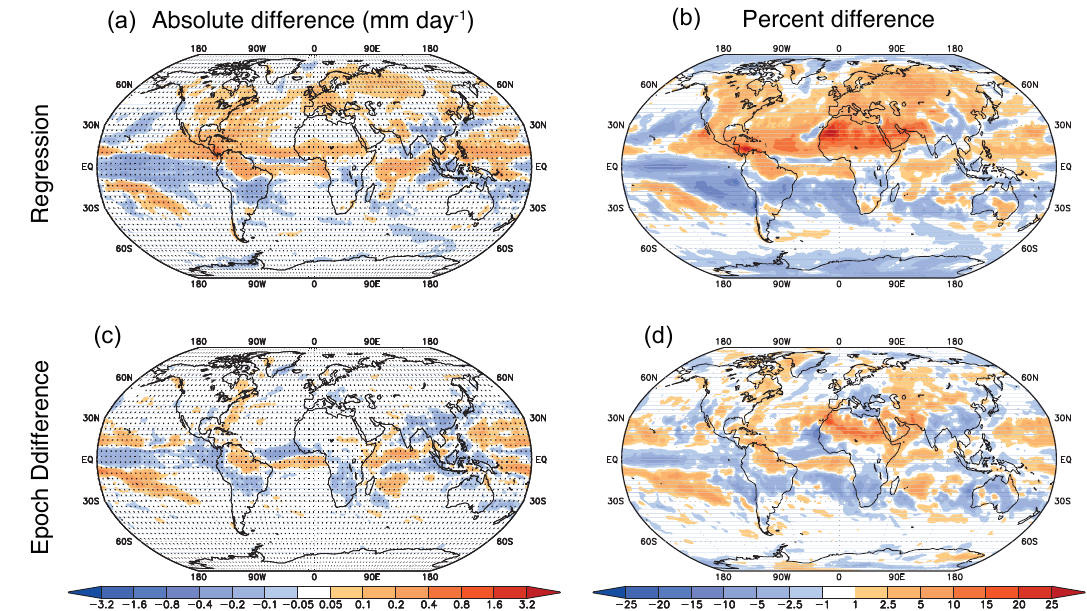
(cid:49) ¯ T RCP8 . 5 , nonCO (227–251) + P 1pctCO2 (cid:49) ¯ T RCP8 . 5 , CO 2 2